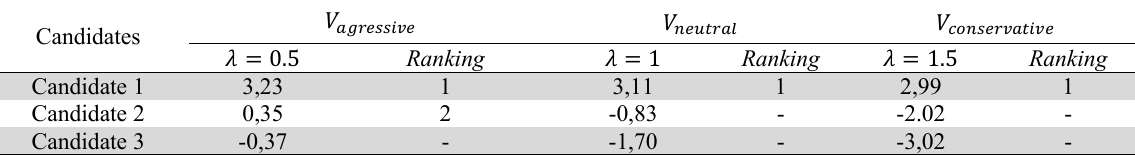
Ranking of the Behavioral TOPSIS Value